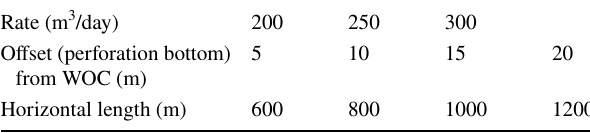
Table 5 Sensitivity parameters for horizontal